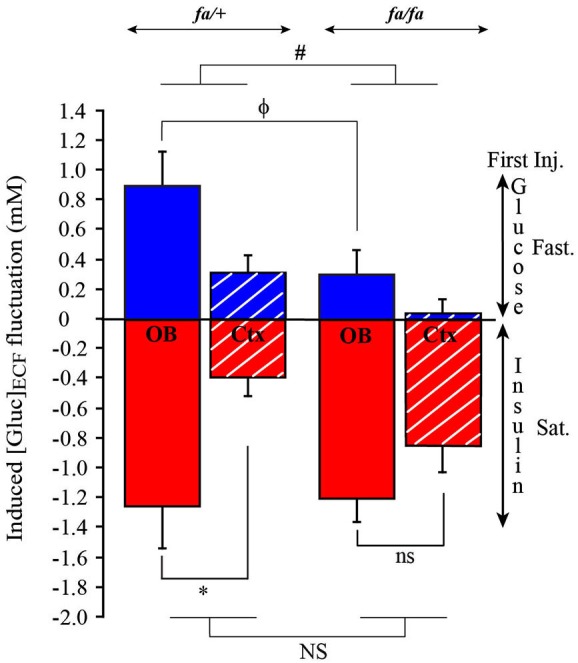
Genotype effect on [Gluc]ECF fluctuations induced by the first injection of either Glucose or Insulin in OB and cortex. Bars represent the difference calculated between [Gluc]ECF measured at steady state and after the first injection of glucose (blue) or insulin (red). [Gluc]ECF fluctuations were observed in OB (full bar) and cortex (Ctx, dotted bar) of lean fa/+
(left) and obese fa/fa rats (right). When glucose was injected in first in fasted rats (Fast.), a significant effect of the genotype on [Gluc]ECF fluctuation was observed (ANOVA test, #
P < 0.05; NS P > 0.05), [Gluc]ECF fluctuation being smaller in the OB of fa/fa compared to fa/+ rats (Mann Whitney, ϕ
P < 0.05). No difference was observed in the Ctx. When insulin was injected in first in satiated rats (Sat.), only in fa/+ rats [Gluc]ECF fluctuation was significantly higher in OB than in cortex (Mann Whitney, * P < 0.05; ns P > 0.05).